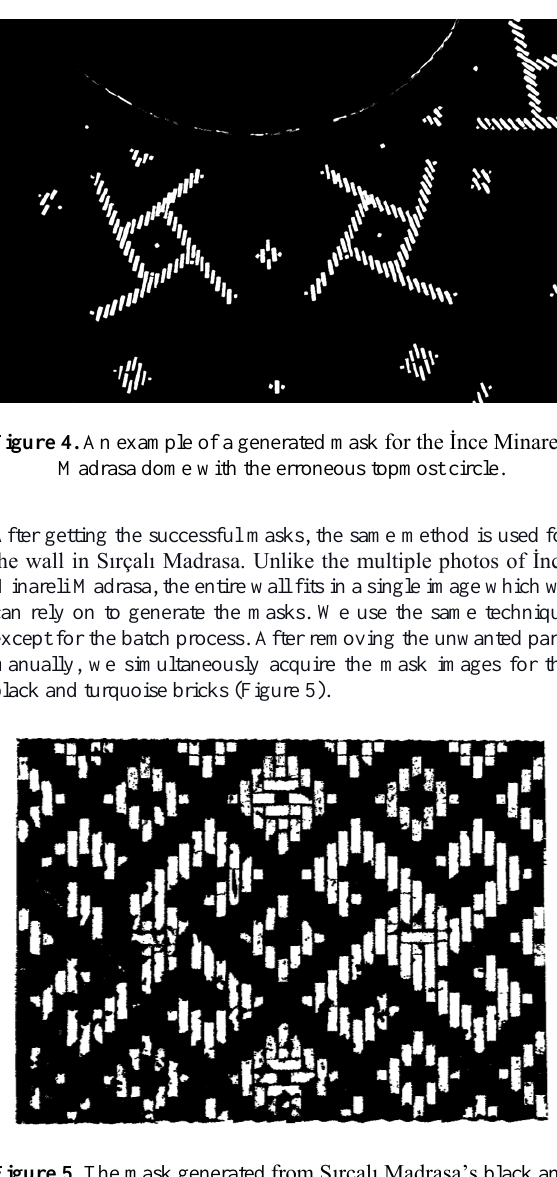
Figure 5. The mask generated from Sırçalı Madrasa’s black and turquoise bricks combined.